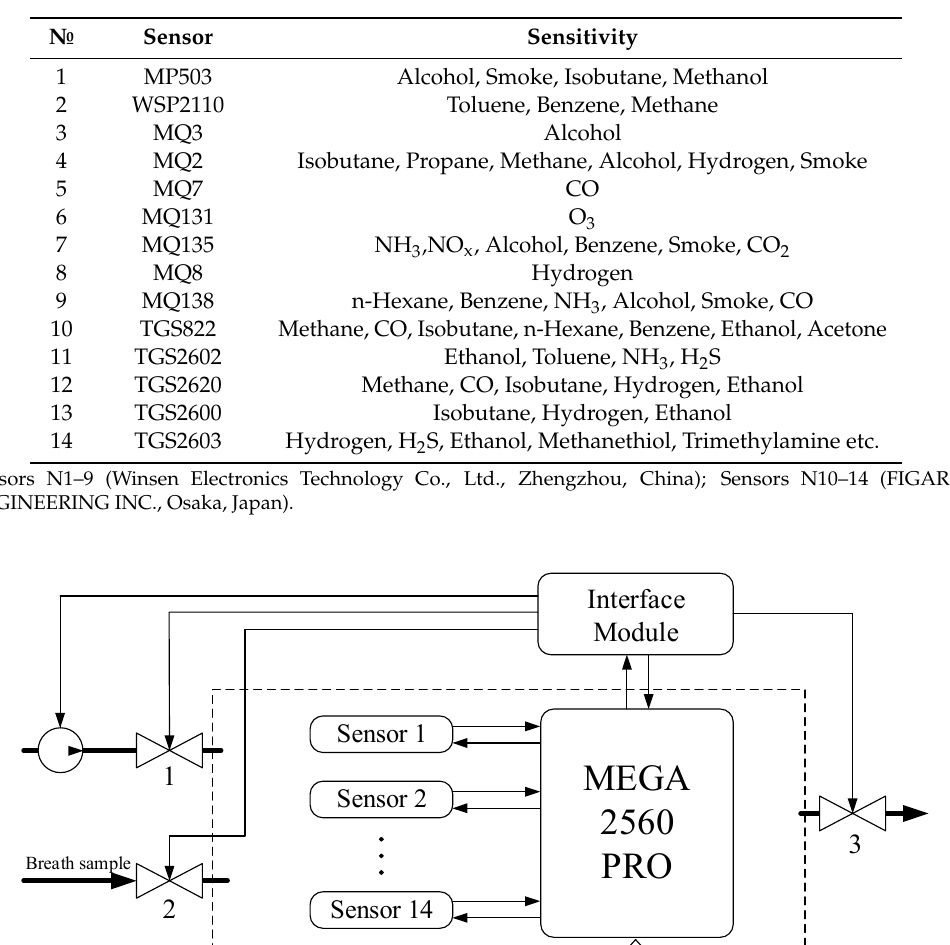
Table 2. Sensors as part of a gas analytical system.